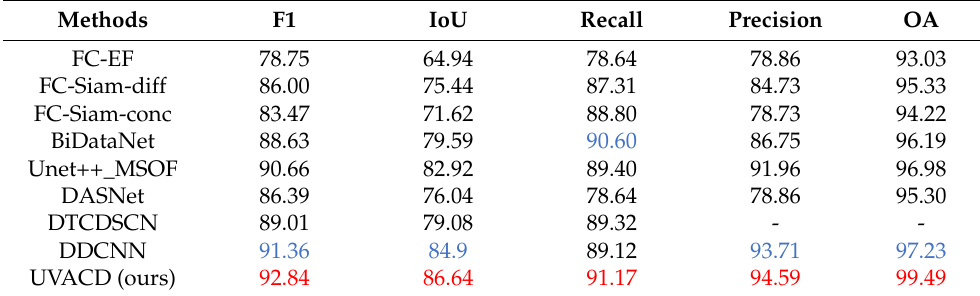
Table 2. The average quantitative results obtained by different CD methods on WHU test set. (largest in red, second-largest in blue; all values are reported as percentages